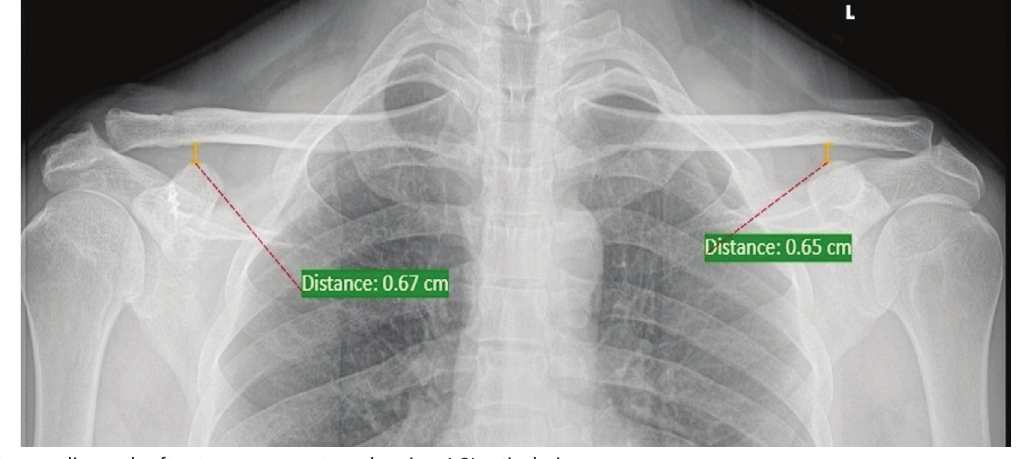
Fig. 3: Stress radiograph after two years post-op showing ACJ articulation.